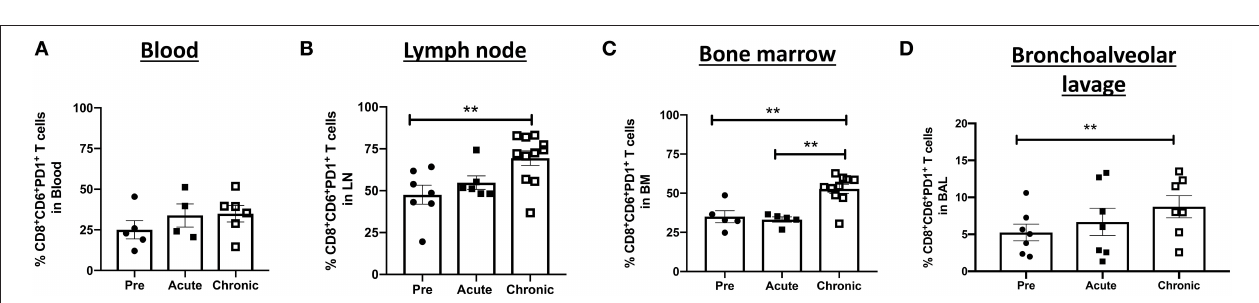
FIGURE 2 | Dynamics of CD6 and PD-1 expressing CD8 + T-cells over the course of SIV-infection. The frequency of CD8 + CD6 + PD-1 + T-cells in the (A) blood, (B) inguinal LN, (C) bone marrow, and (D) BAL at different time points following SIV infection. Data for the blood are from 4 to 6 macaques, data for the LN are from 7 to 11 macaques, data for the bone marrow are from 5 to 10 macaques, data for BAL are from 7 macaques. For statistical analysis, Kruskal-Wallis with Dunn’s multiple comparison tests were performed. ** p < 0.01.